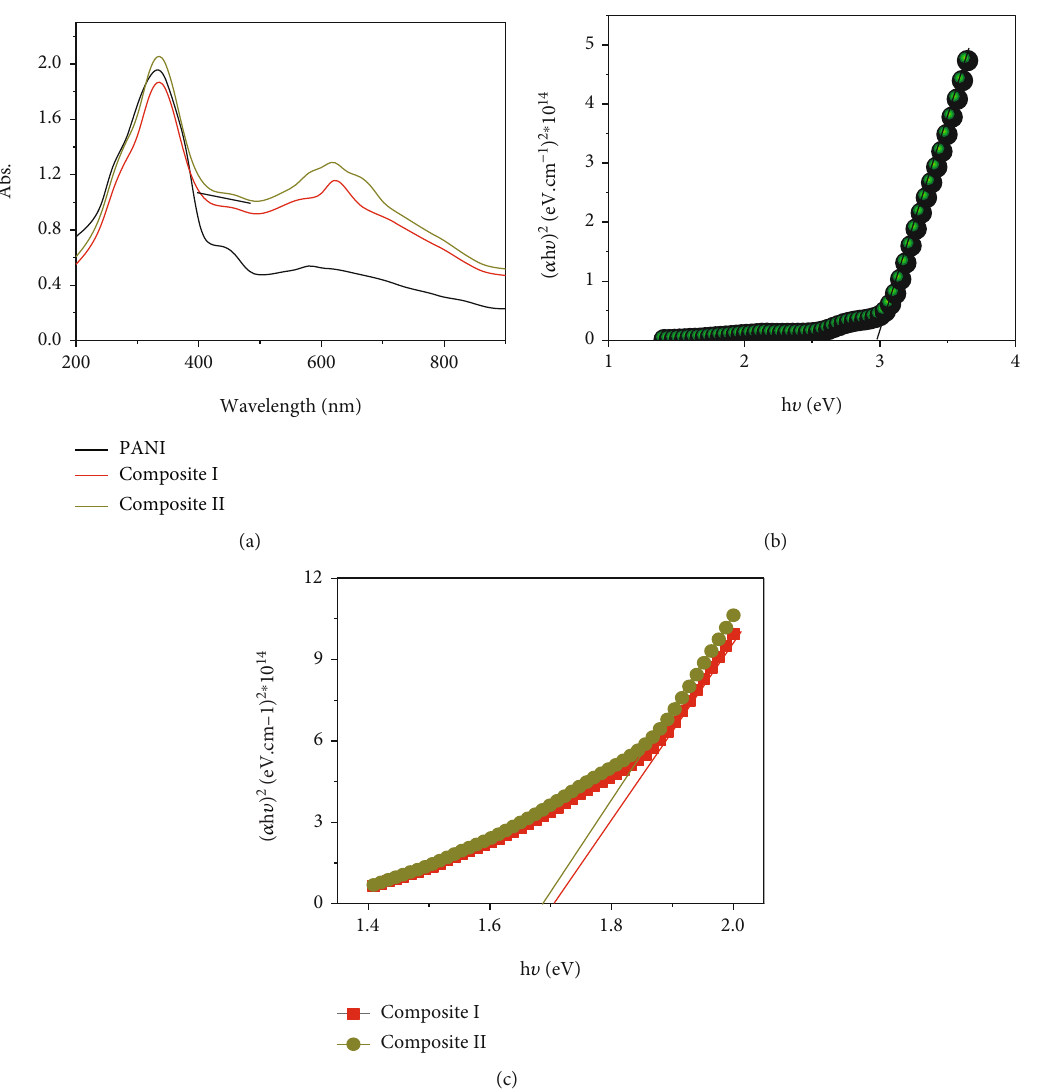
Figure 4: (a) Optical absorbance of PANI and composites I and II. Bandgap values of (b) PANI and (c) PANI/Ag